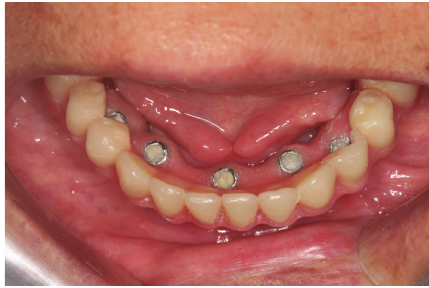
Figure 12: Screwed mandibular denture and its relation to the tissues of the buccal floor.